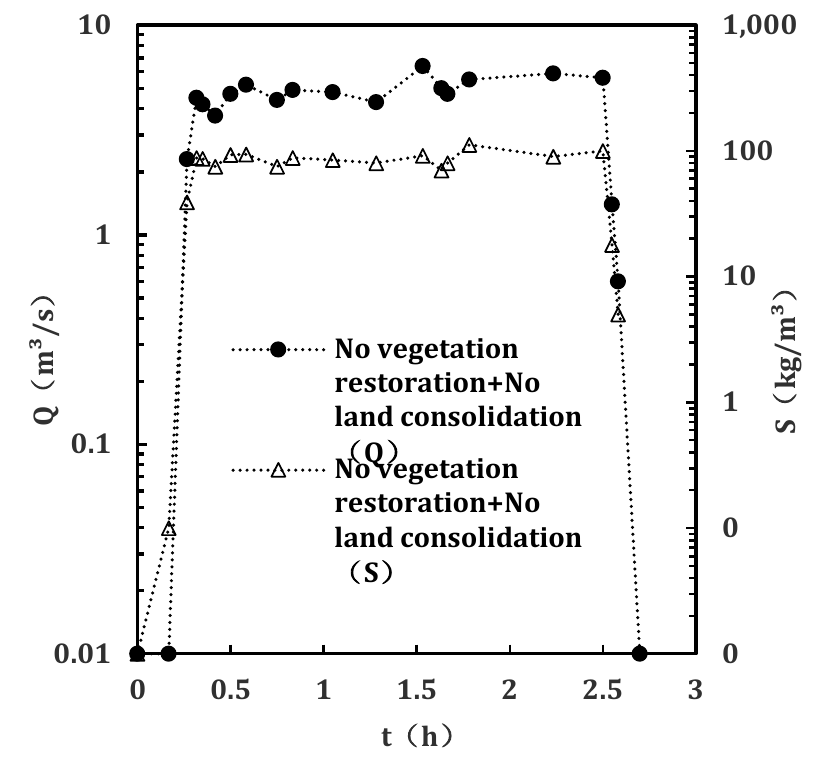
Figure 18. Changes in flow and sediment content before watershed control.